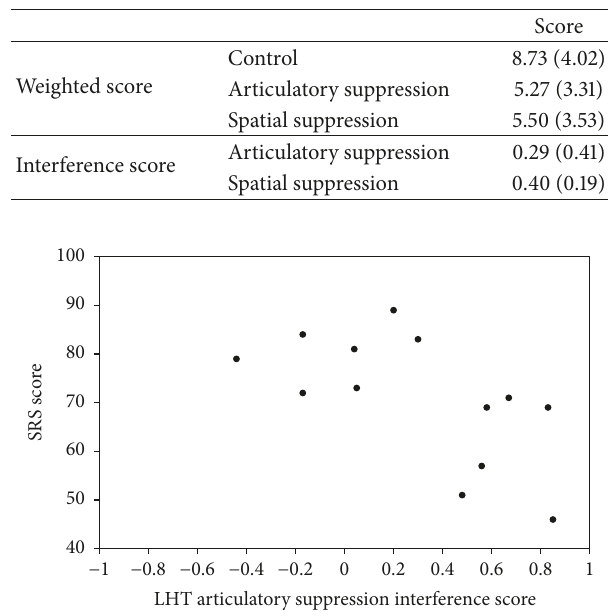
Table 1: Means and standard deviations of each condition in children with ASD.